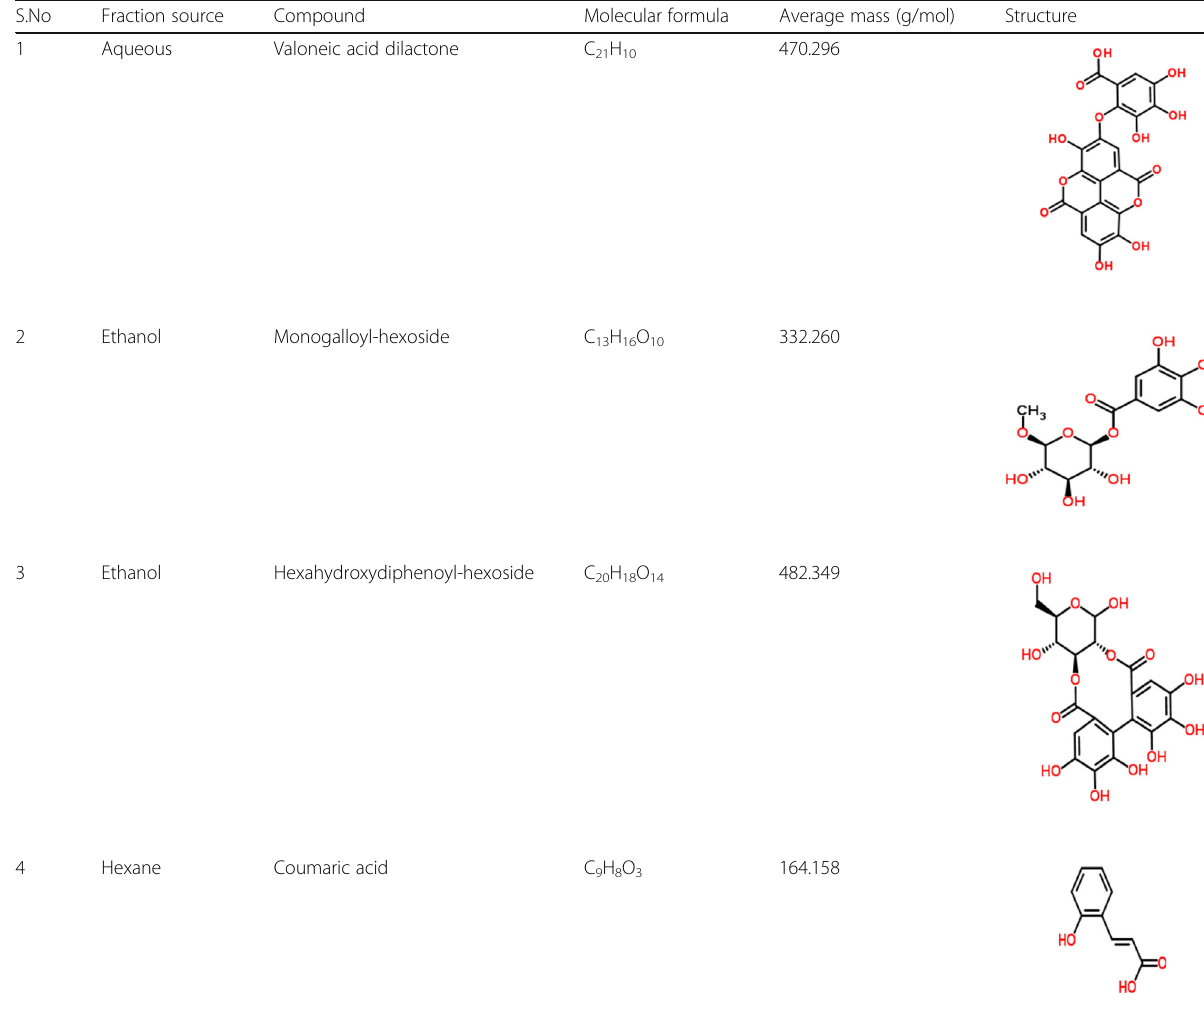
Table 2 Chemical characteristics of identified compounds from P. granatum peel by LC MS/MS S.No Fraction